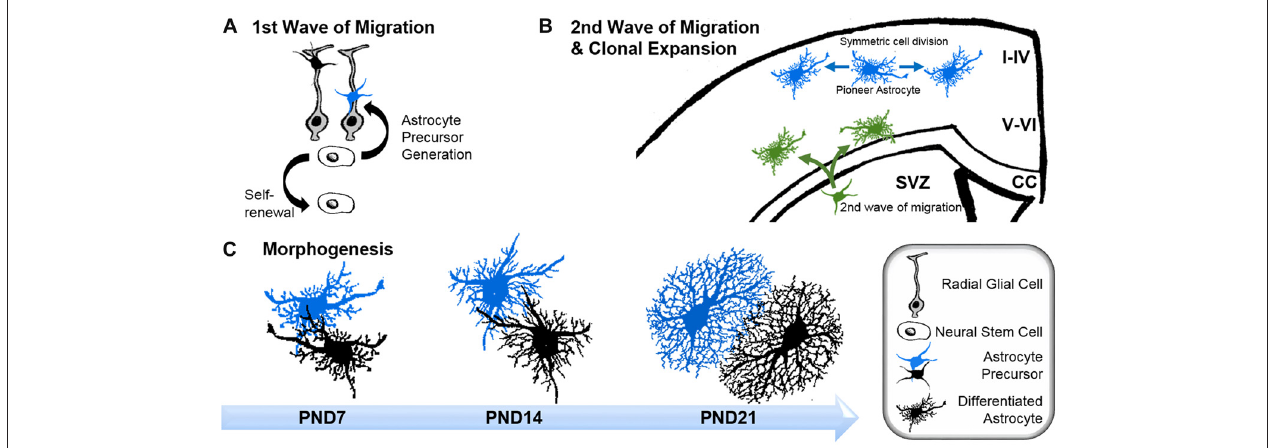
FIGURE 1 | Astrogenesis and morphogenesis of astrocytes during development. (A) First wave of progenitor migration: asymmetric division of neural stem cells within the ventricular zones creates the first wave of astrocyte precursor cells (black and blue), which migrate along the processes of radial glial cells (gray) towards their final location in the central nervous system (CNS). (B) Clonal expansion of pioneering astrocytes and second wave of migrating astrocyte progenitor during late development: pioneering astrocytes of the first migration wave (blue) undergo symmetric cell division in the upper cortical layers, while a second wave of astrocyte progenitors emerges from the subventricular zone (SVZ; green), predominantly colonizing the lower cortical layers. Corpus callosum (CC). (C) Time course of astrocyte morphogenesis during postnatal development, demonstrated by two neighboring astrocytes (blue and black). Differentiating astrocytes possess long main processes at postnatal day (PND) 7, which invade the domains of neighboring astrocytes. At PND14, ramification into smaller processes has increased, whilst the extent of invasion into domains of neighboring astrocytes is reduced. Three weeks after birth, at PND21, astrocytes have acquired their complex morphologies within their distinct domains. At this stage, only very limited intermingling with neighboring astrocytes occurs.